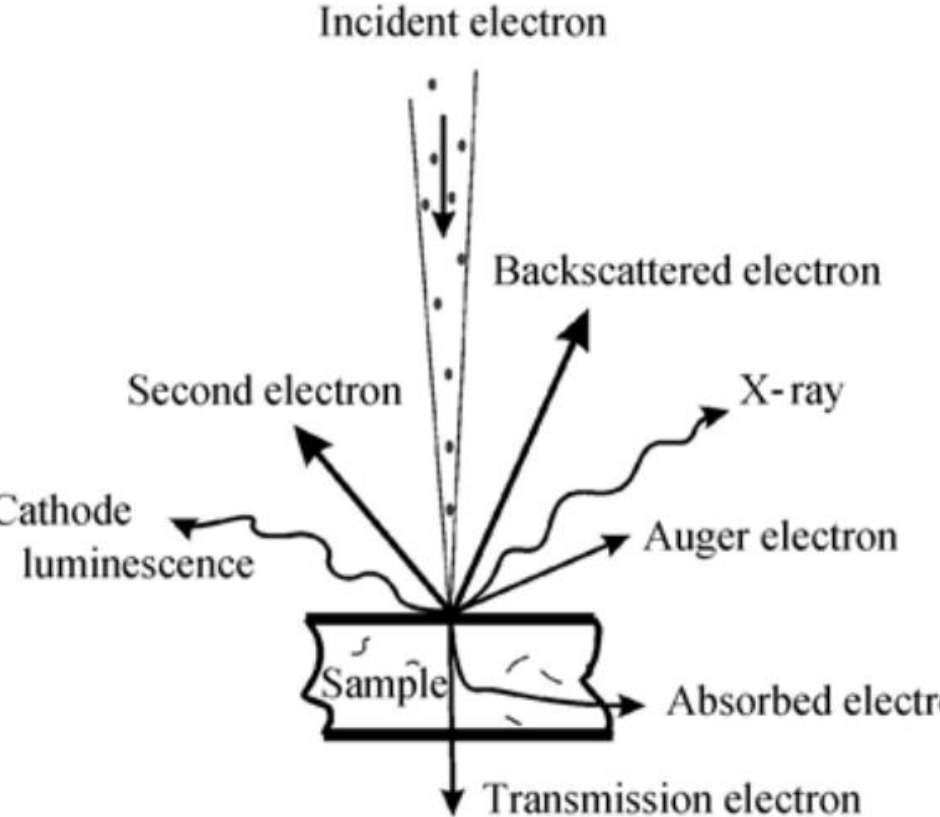
Figure 3. Signals excited when the incident electron interacted with the